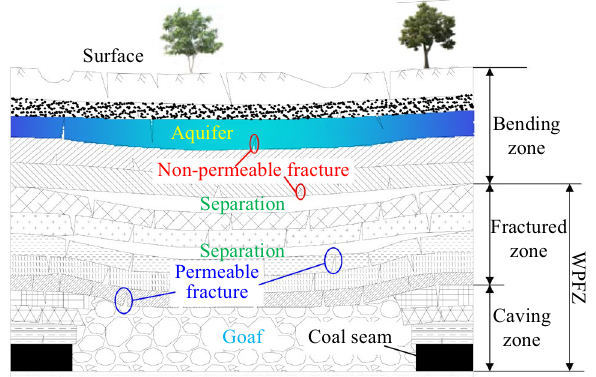
Figure 1. Caving zone, fractured zone and bending zone in the overlying strata after mining (This figure is drawn by the AutoCAD 2018, https:// www. autod esk. com. cn/ produ cts/ autoc ad/ overv iew? term=1- YEAR& tab= subsc ripti